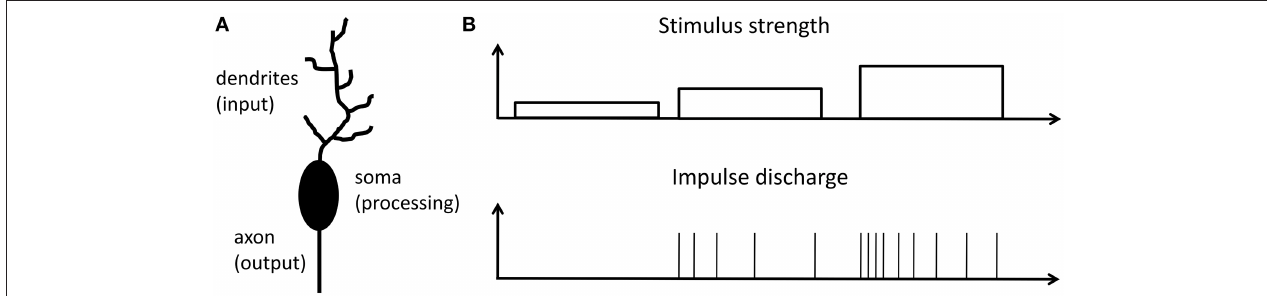
FIGURE 1 | Response to a stimulation principle: (A) Schematic of a single neuron, which can be divided into three functional parts: Dendrites, collect signals from other neurons; cell body (soma), the central processing unit of a neuron; axon, neuronal output stage. (B) Relationship between firing rate of a neuron and the strength of input stimulation reflecting the response to a stimulation principle as proposed by E. D. Adrian in 1926 (Adrian, 1926, 1928; Maass and Bishop,